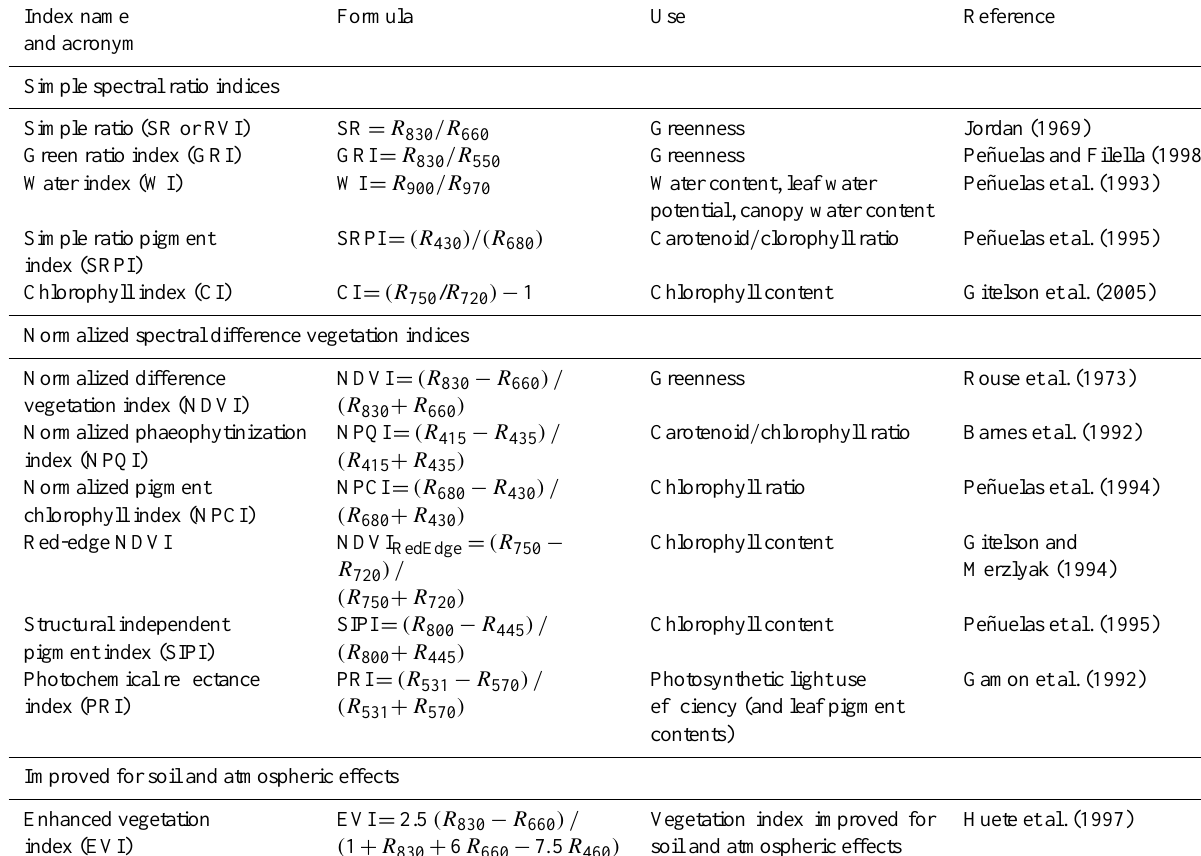
Table 2. Summary of the vegetation indices characteristics used in this